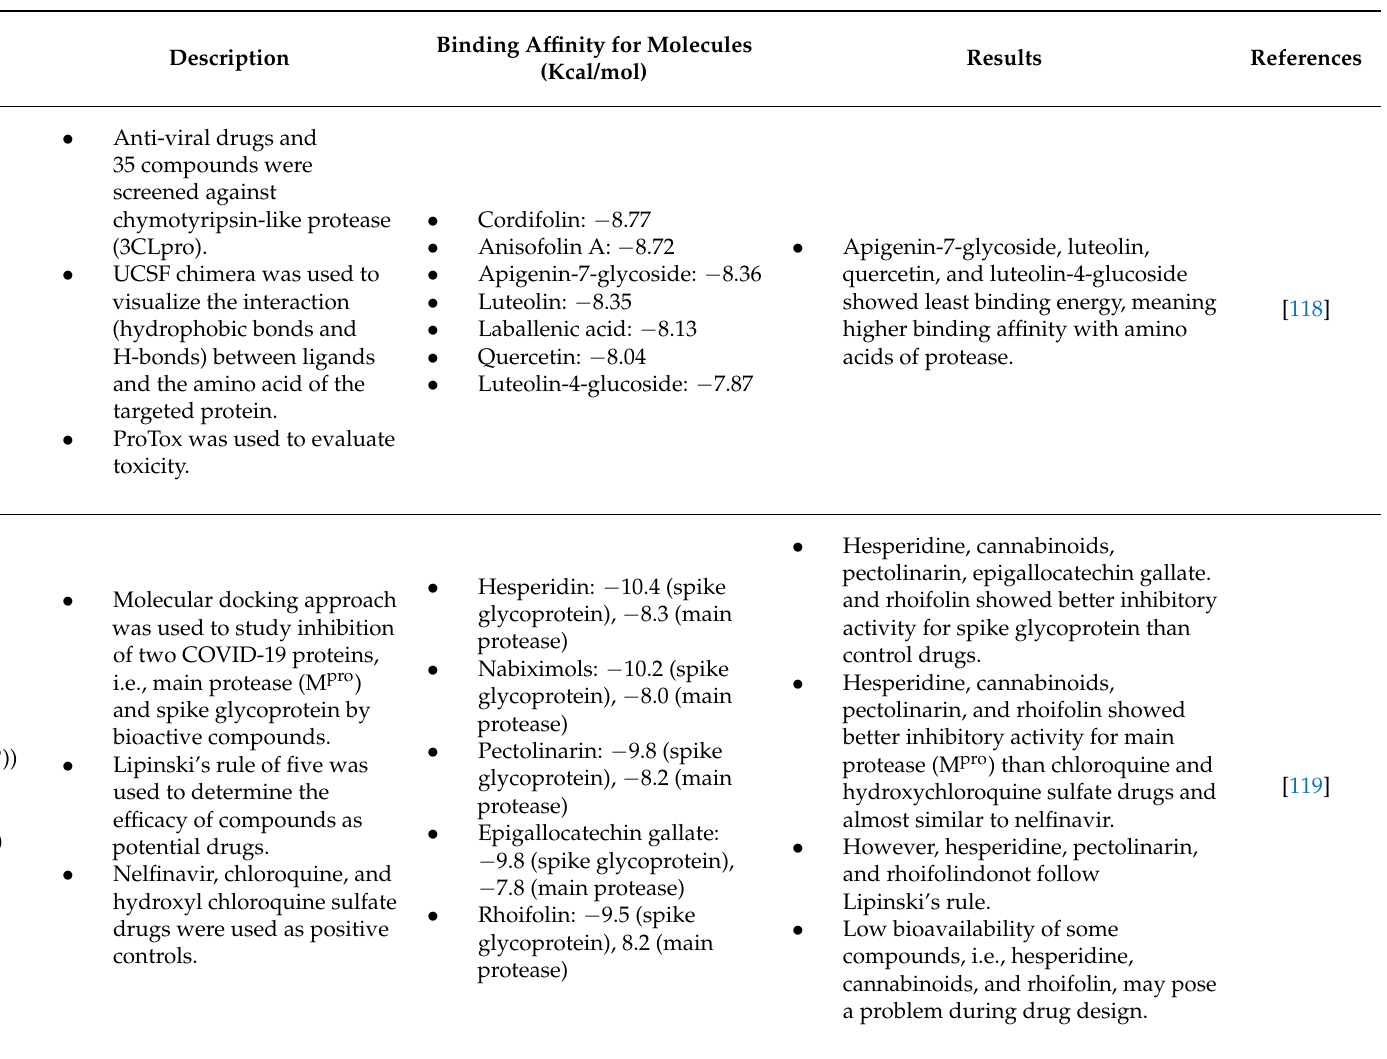
Table 1. Recent in silico studies of flavonoids against